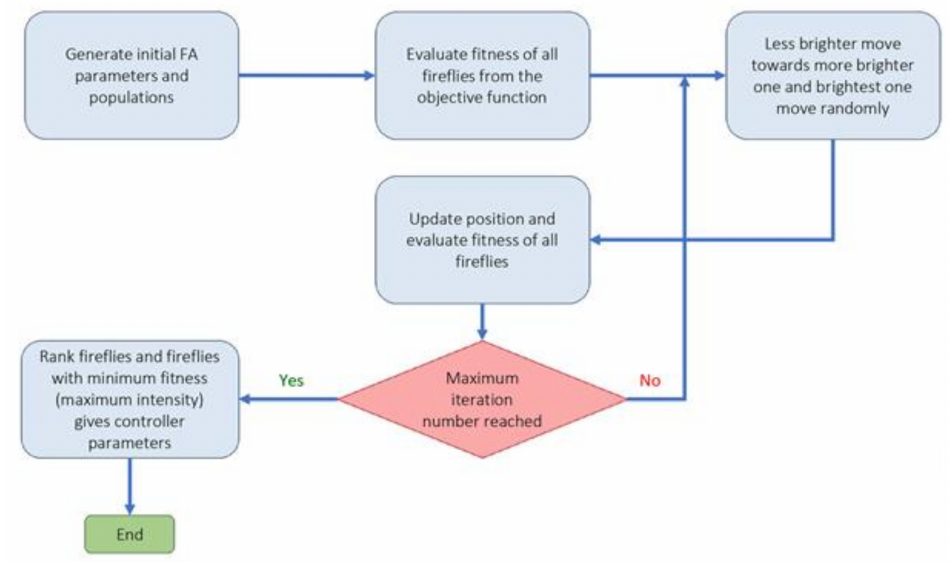
Figure 4. General instruction for problem solving by firefly optimization